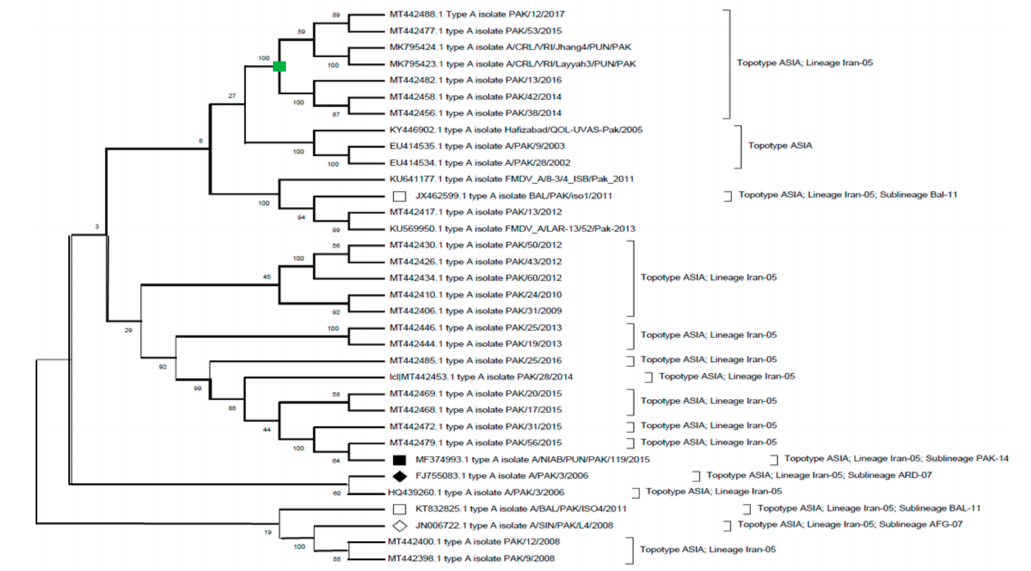
Figure 2. A phylogenetic evolutionary (rooted) tree depicting the relationship between FMDV serotype A isolates of Pakistan that have been retrieved from GeneBank. The VP1 region sequences are used for the comparison of sequences. The phylogenetic tree was constructed with maximum- likelihood method based on Tamura–Nei model. The tree topology robustness was measured with bootstrap values (100 replicates). The values on the nodes show bootstrap